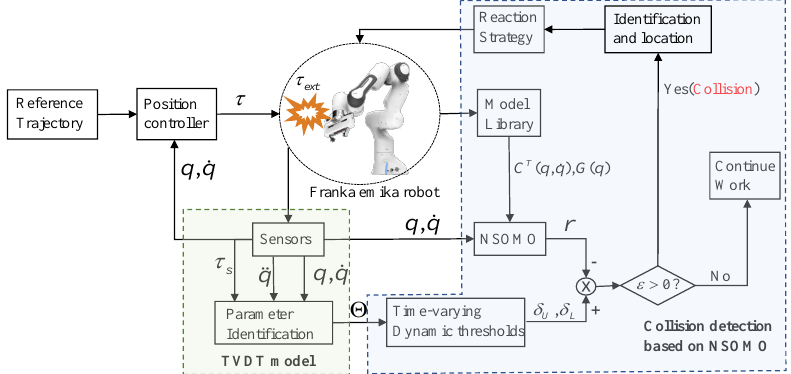
Figure 3. Collision detection procedure schematic block diagram.